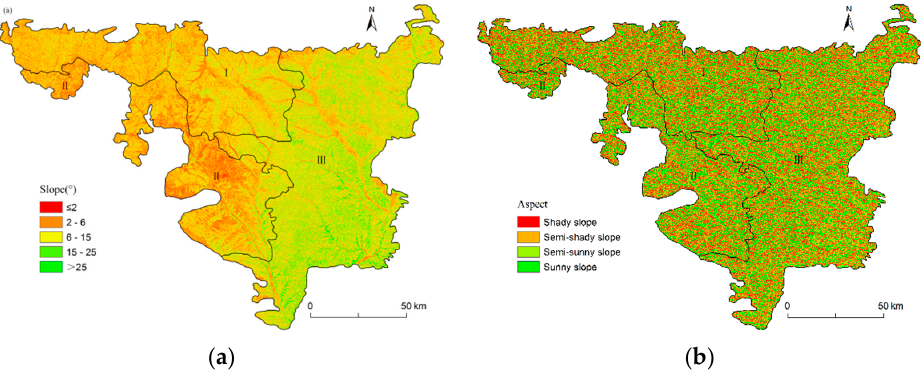
Figure 2. Distributions of slope ( a ) and aspect ( b ) in the Pisha Sandstone area.